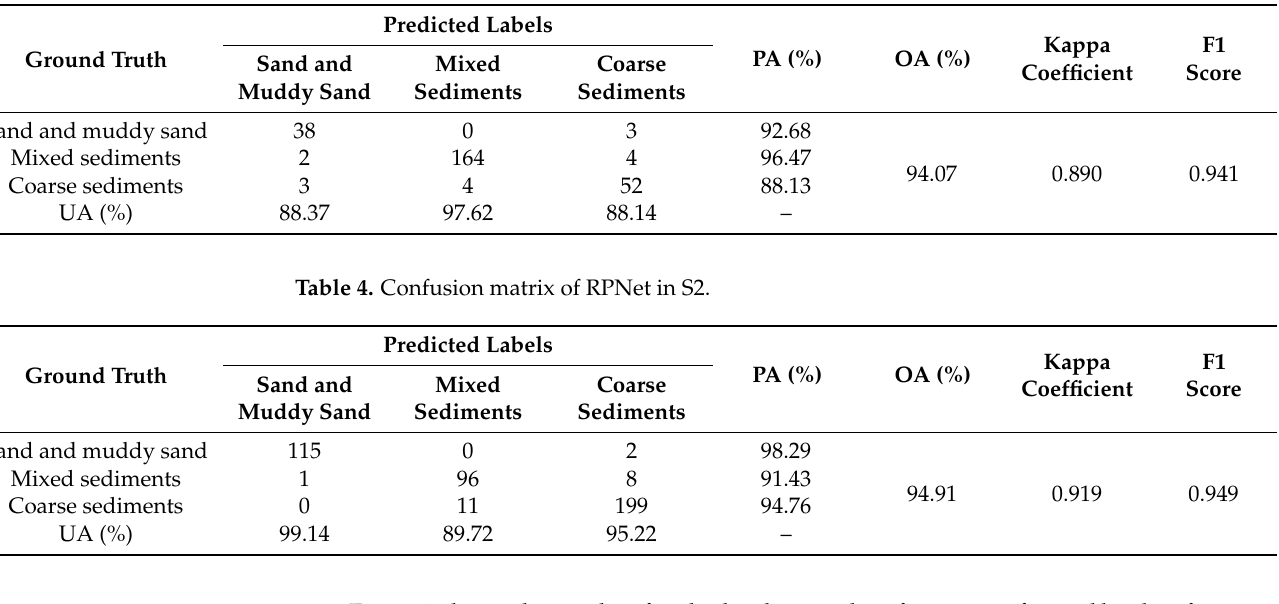
Table 3. Confusion matrix of RPNet in S1.